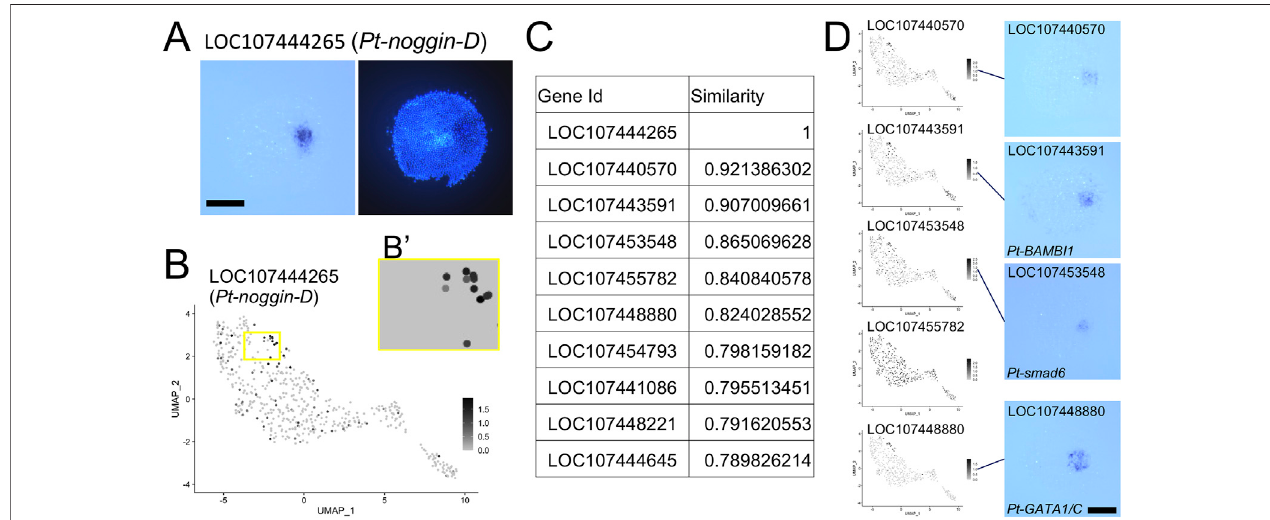
FIGURE6| Identi fi cationofthecumulusontheUMAPplot. (A) ExpressionofLOC107444265( Pt-noggin-D )inagermdiscatlatestage5.Thesignalisdetectedat the cumulus. The right panel shows DAPI staining of the same embryo. (B) Expression of LOC107444265 visualized on the UMAP plot. The region boxed in yellow was used as a template in the Open CV similarity search after the background color was changed to the color of cells without expression as in (B 9 ) . (C) The list of genes with highestsimilarityscoresinthesimilaritysearch. (D) Expressionofthetop6genesexceptLOC107444265visualizedontheUMAPplotanddetectedusingWISH. In situ hybridization of LOC107455782 was not performed. Scale Bars = 200 μ m.